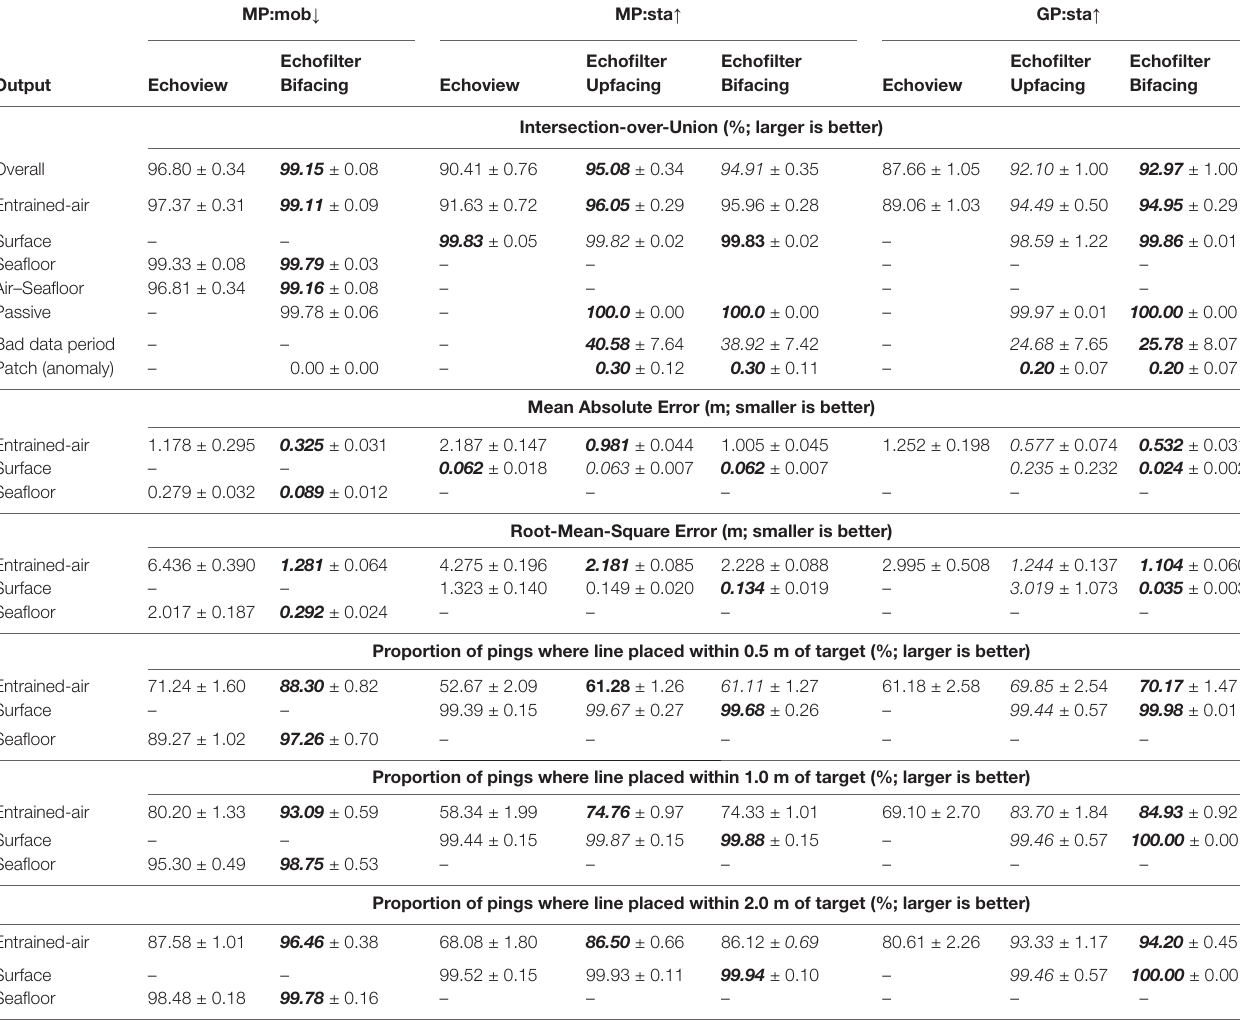
TABLE 2 | Final model performance (agreement with manual annotation) for each